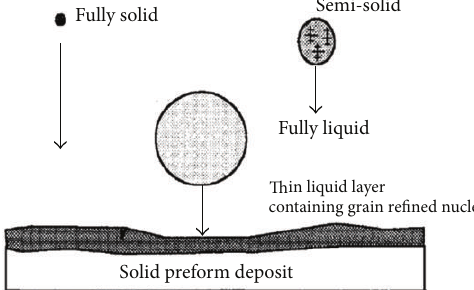
Figure 9: Schematic illustration of formation and structure of the spray process [25].